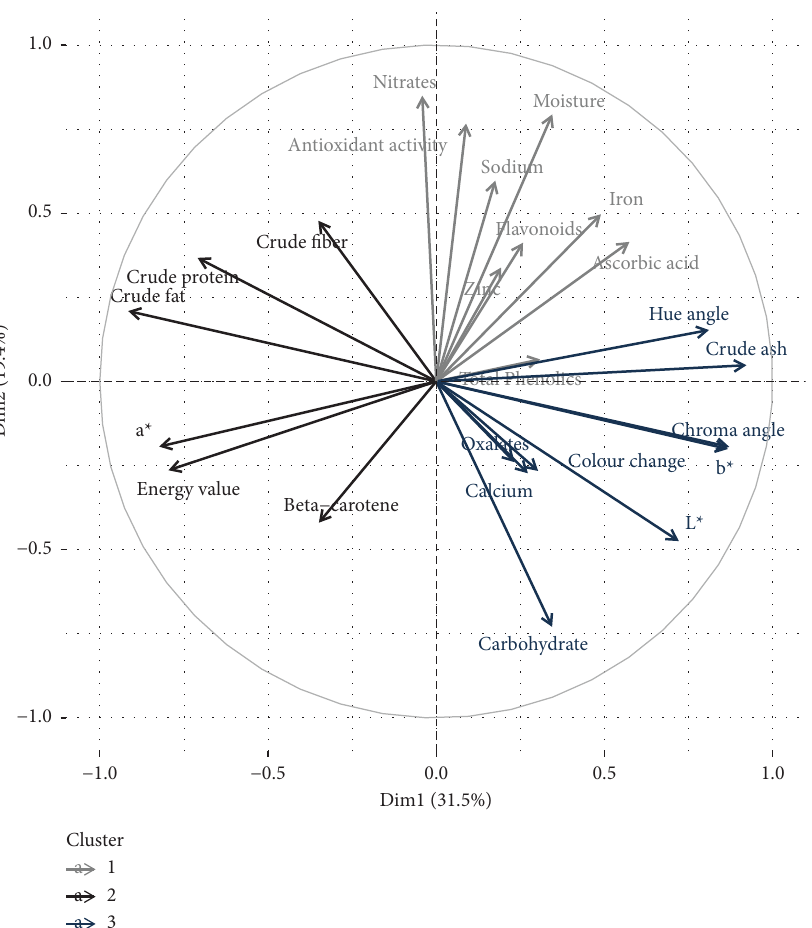
Figure 3: Correlation of plots showing clustering of the physical and chemical attributes of locally processed cowpea